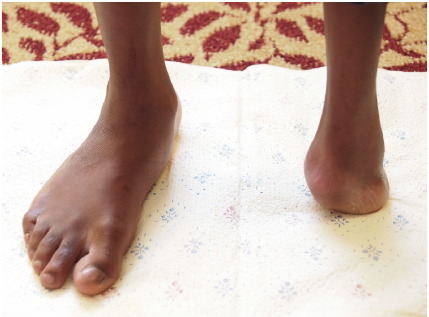
Figure 1: Transverse deficiency of the left lower extremity in Mobius Syndrome (anterior view).